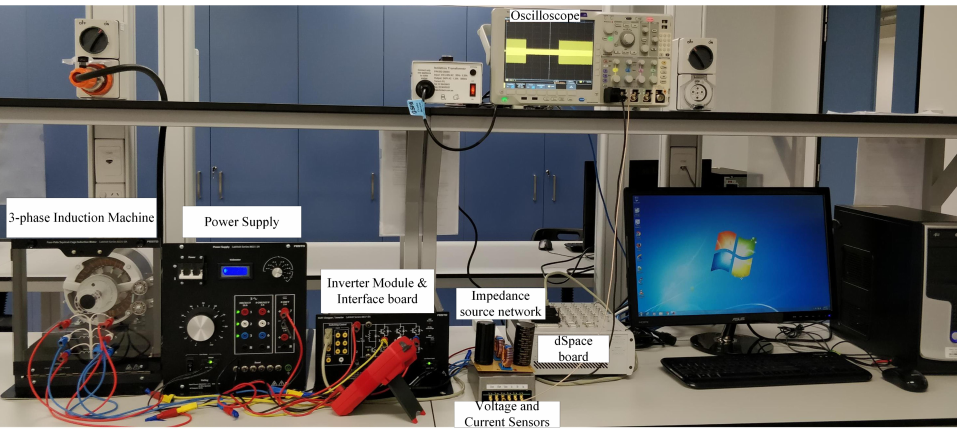
Figure 11. Experimental